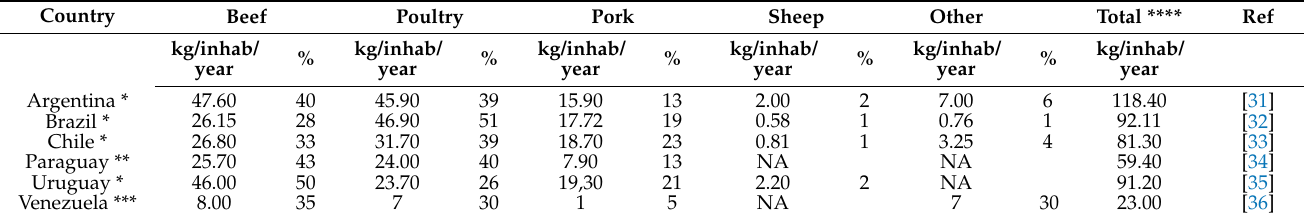
* Value reported for 2021. ** Values reported for 2020. *** Values reported for 2018 **** Total consumption and share are calculated based on the values reported in the table. NA: not